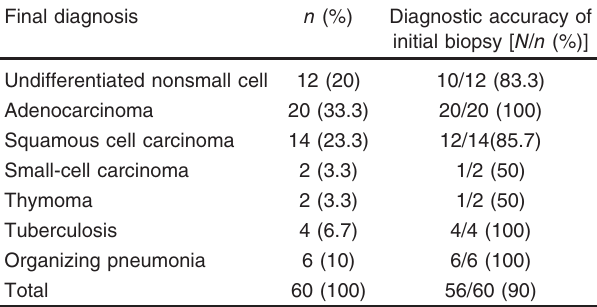
Table 3 Final histopathological diagnosis of biopsy Final diagnosis n (%) Diagnostic accuracy of initial biopsy [ N / n (%)]